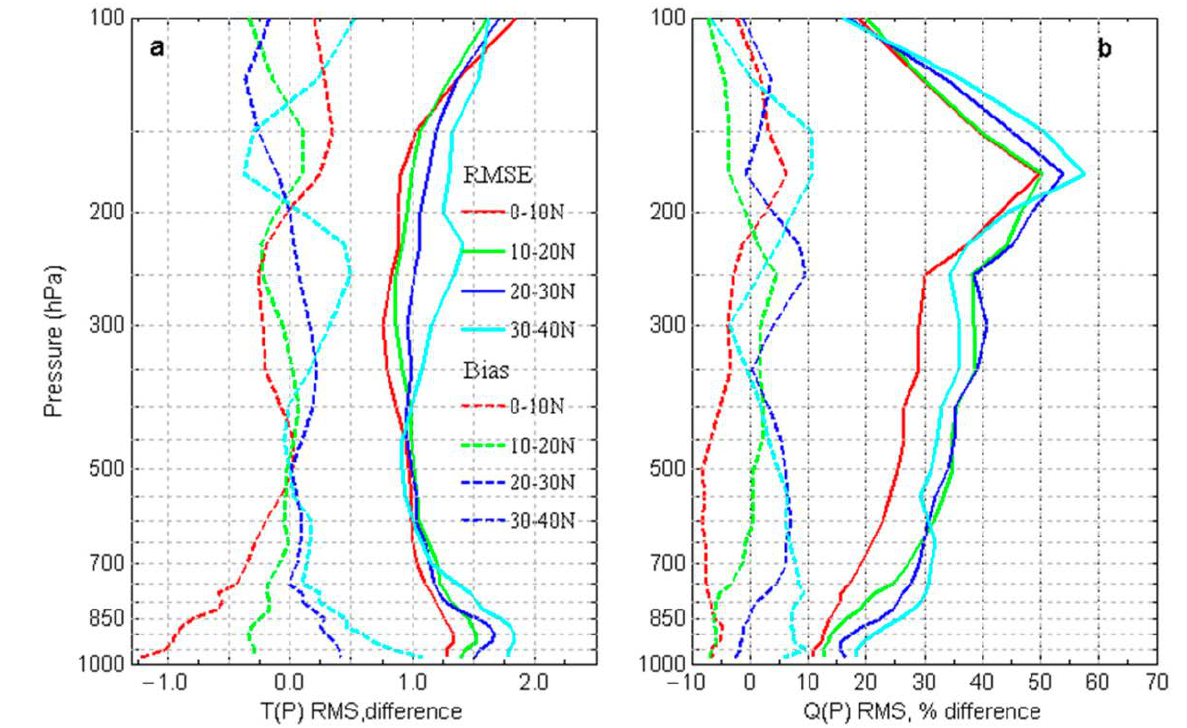
Figure 12. The RMSE and bias of the temperature ( a ) and relative humidity ( b ) profiles between the retrieval results and ERA5 data in different 10 ◦ latitudinal bands.